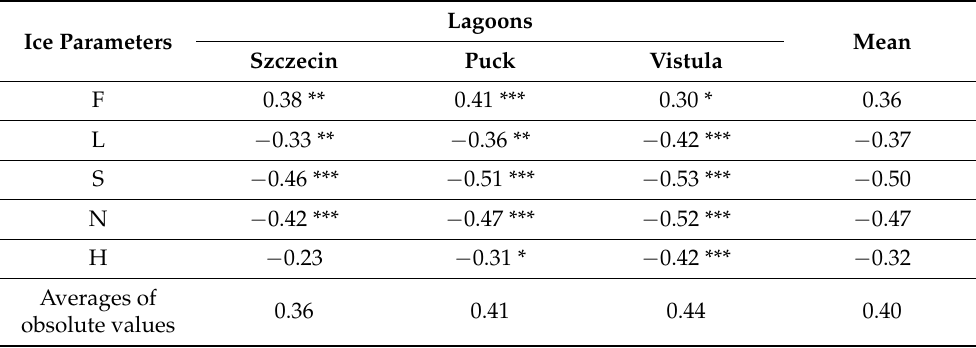
Table 6. Correlation coefficients of linear trends of ice parameters (designations as in Table 2) in southern Baltic coastal lagoons